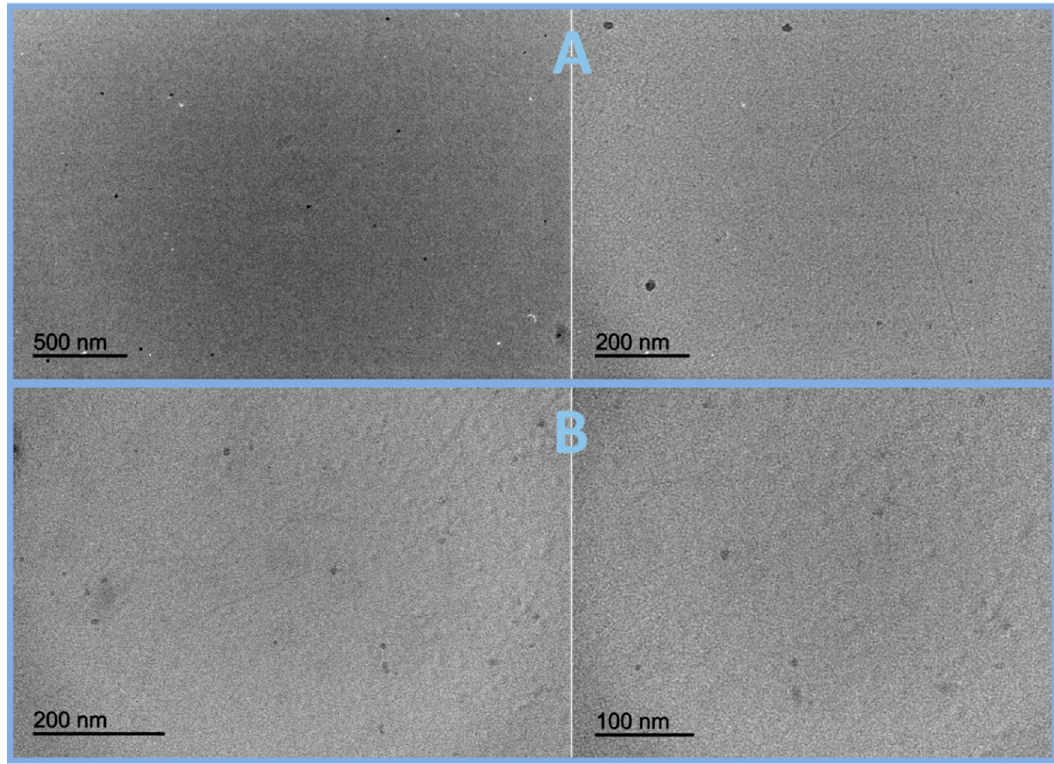
Figure 2. Transmission electron microscopic images of o-GQDs ( A ) and e-GQDs ( B ) whose diameters ranging 5–24 and 5–16 nm, respectively.